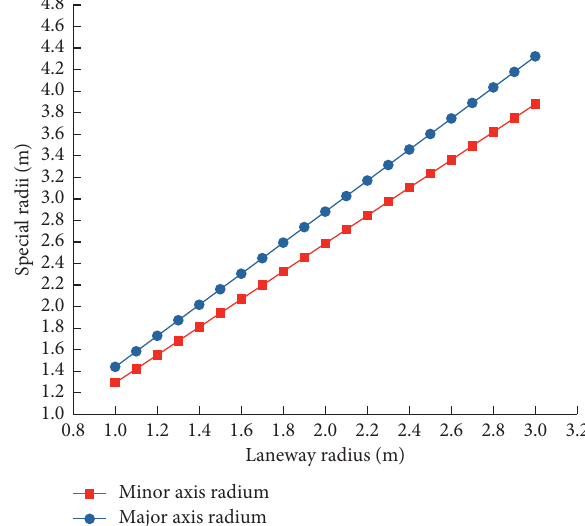
Figure 6: The relationship between special radii and laneway radius.